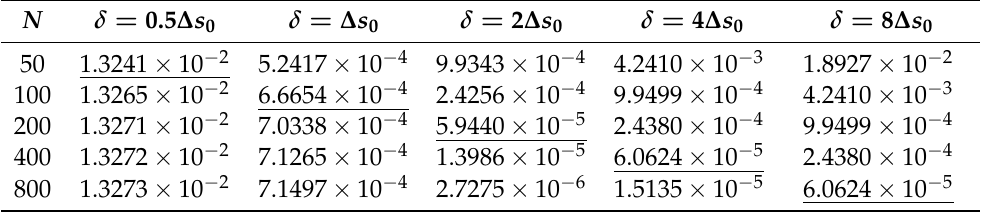
Table 2. Errors in the circle radius in example 2 using the blob φ δ . The errors were computed as max t | R ( t ) − R exact ( t ) | . The initial arc length discretization is defined as ∆ s 0 = 2 π R 0 / N . The underlined values correspond to errors for a fixed value of δ .